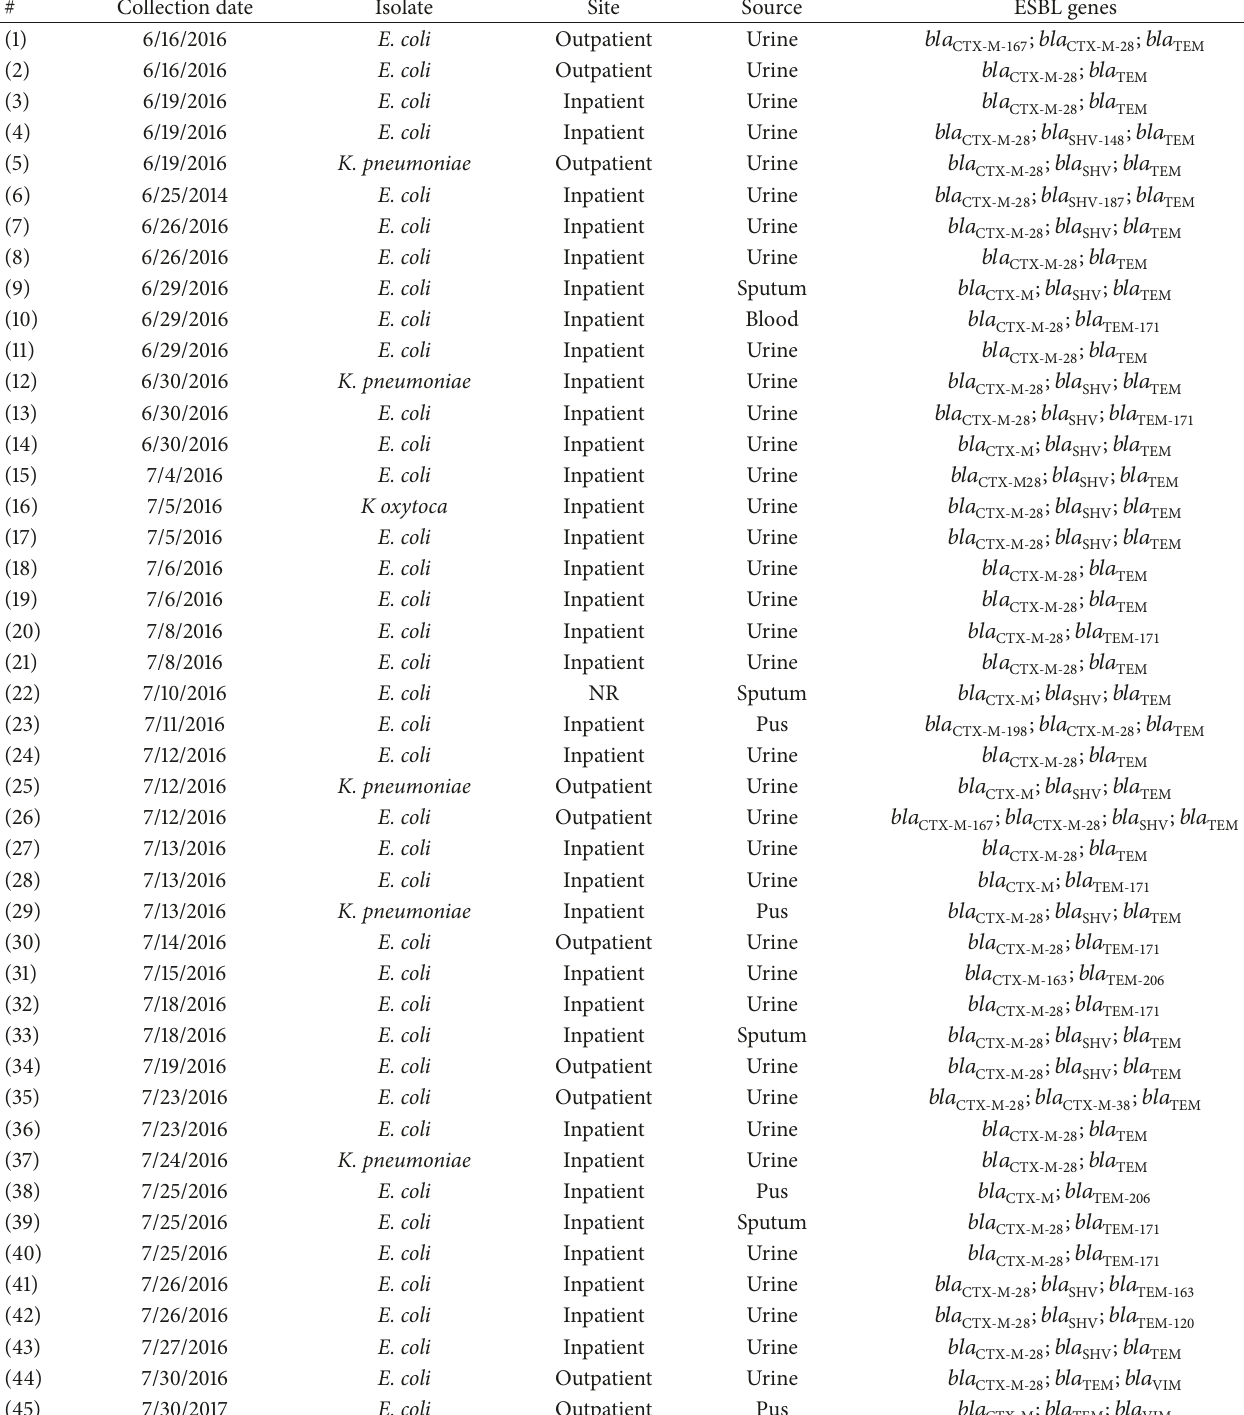
Table 1: Distribution of isolates and ESBL